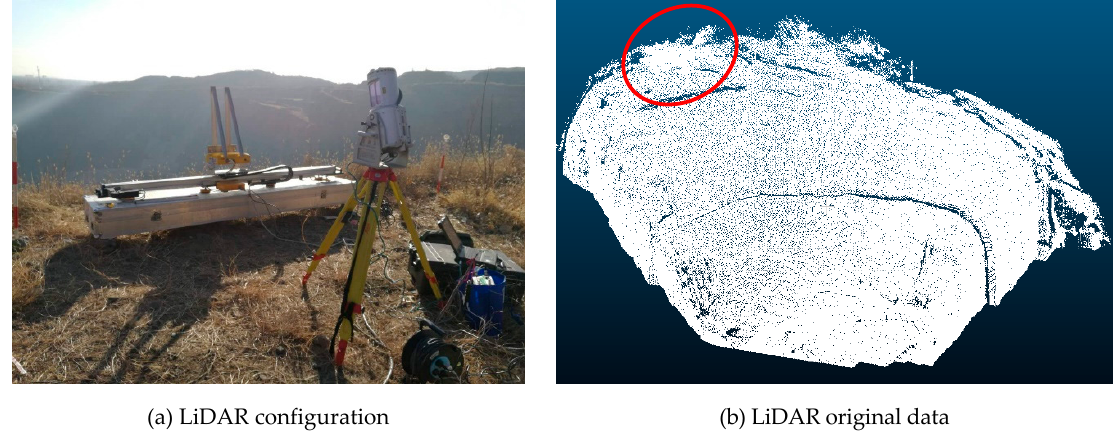
Figure 8. Light detection and ranging (LiDAR) configuration and its original data.